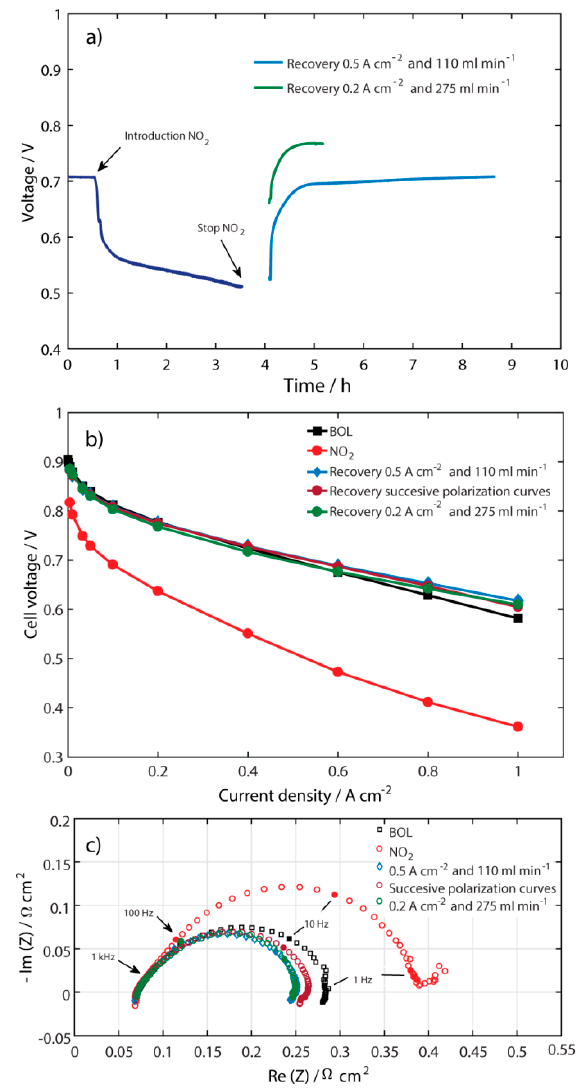
Figure 4. ( a ) Performance with 100 ppm NO 2 , recovery at 0.5 A cm − 2 and 110 ml min − 1 , and recovery at 0.2 A cm − 2 and 275 ml min − 1 ; ( b ) Polarization curves at BOL, after contamination with NO 2 , after recovery at 0.5 A cm − 2 and 110 mL min − 1 , after recovery by successive polarization curves with 110 mL min − 1 as a constant air flow, and after recovery at 0.2 A cm − 2 and 275 mL min − 1 ; and ( c ) EIS spectra for the measurements done in ( b ).